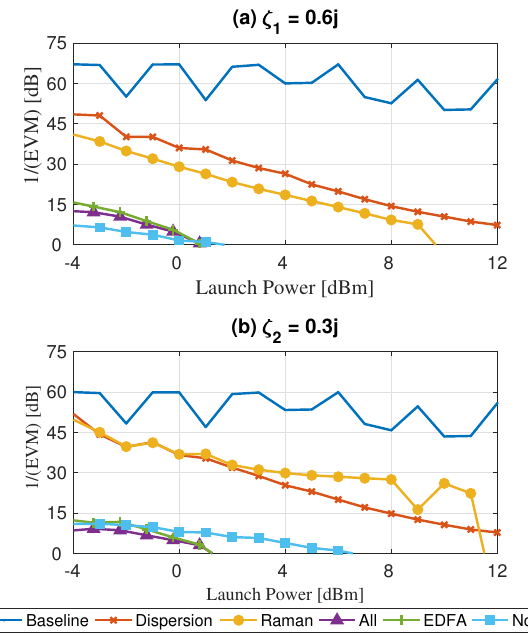
Figure 15. The reciprocal of the EVM as a function of the launch power when all the effects are included and the symbol period is equal to T S2 = 2 T S1 . ( a ) Results of the signal decoded from the first eigenvalue ζ 1 = 0.6 j . ( b ) Results of the signal decoded from the second eigenvalue ζ 2 = 0.3 j . We extended this study to include third-order solitons. Due to excessive ISI in this system, it was not possible to use a third-order soliton with symbol period T S1 . This